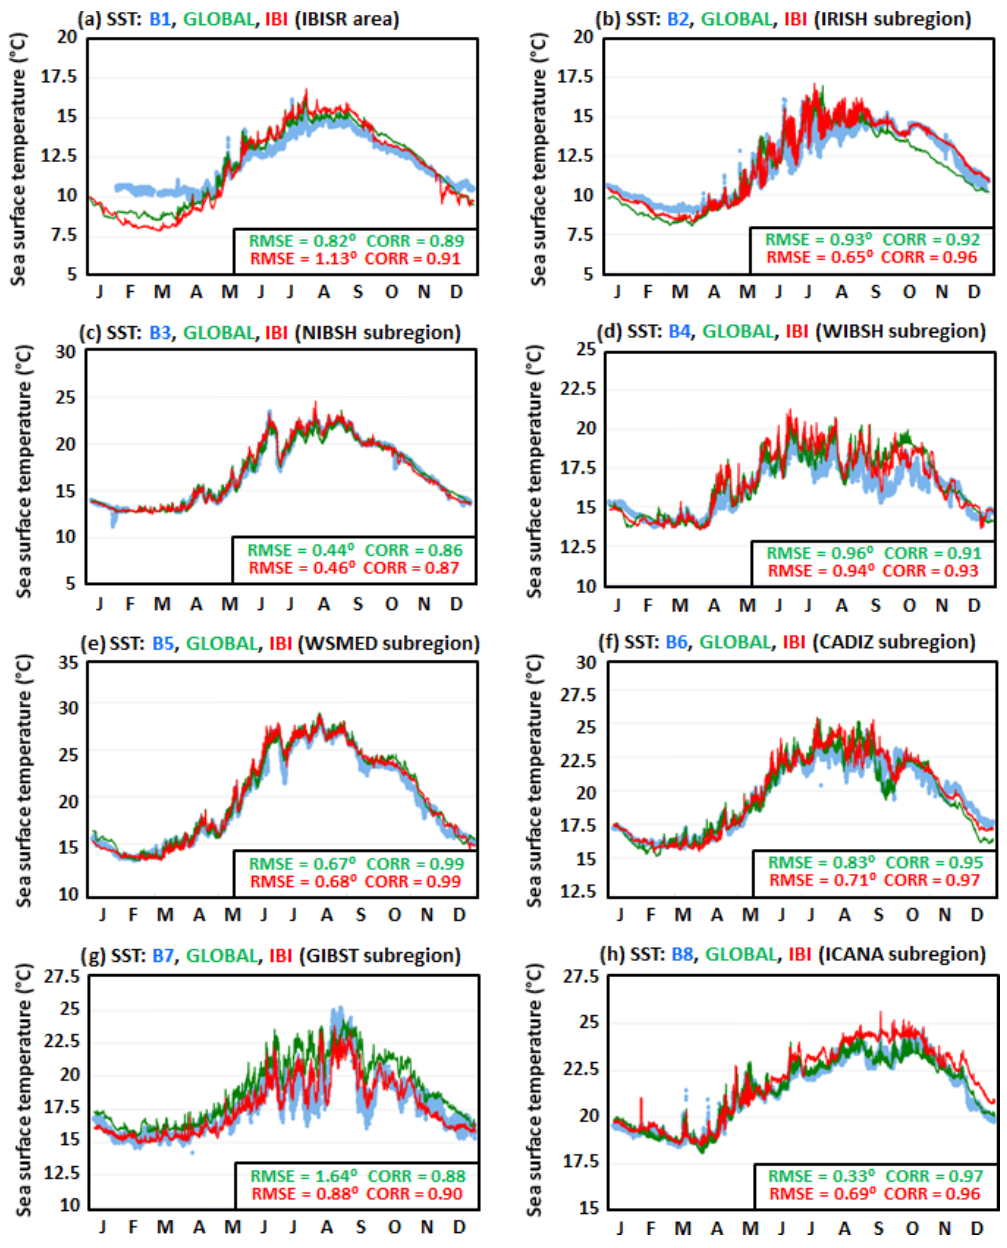
Figure 4. Annual (2017) time series of hourly sea surface temperature (SST) at eight different locations within IBISR area. In situ observa- tions from moored buoys (blue dots), GLOBAL model predictions (green line), and IBI model outputs (red line) are depicted. Skill metrics derived from model–observation comparison are gathered in black